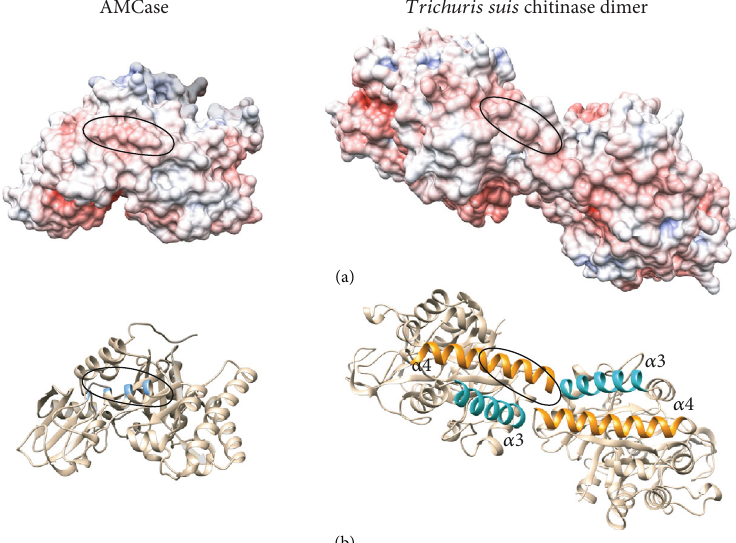
Figure 8: Electrostatic surface representation of mammalian AMCase (PDB 3FY1) and the Ts -Chit dimer. (a) In the Ts -Chit dimer, a surface patch of similar charge and shape as observed in mammalian AMCase is formed. The similar, acidic surface patch in both molecules is circled. (b) Cartoon rendering of AMCase and Ts -Chit in the same orientation as in the upper panel. The location of the circled residues in AMCase is highlighted in blue. Helices α 3 and α 4 contributing to the dimer formation in Ts -Chit are colored turquoise and orange, respectively. The surface electrostatics were calculated with APBS and visualized with UCSF